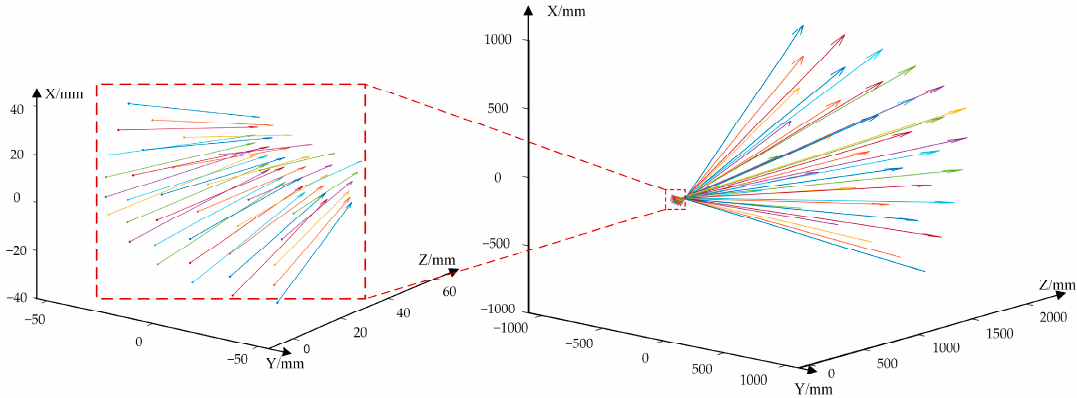
Table 2. The reprojection error under the initial parameters and optimized parameters. Figure 12. The distribution of partial virtual camera Figure 12. The distribution of partial virtual camera boresights.